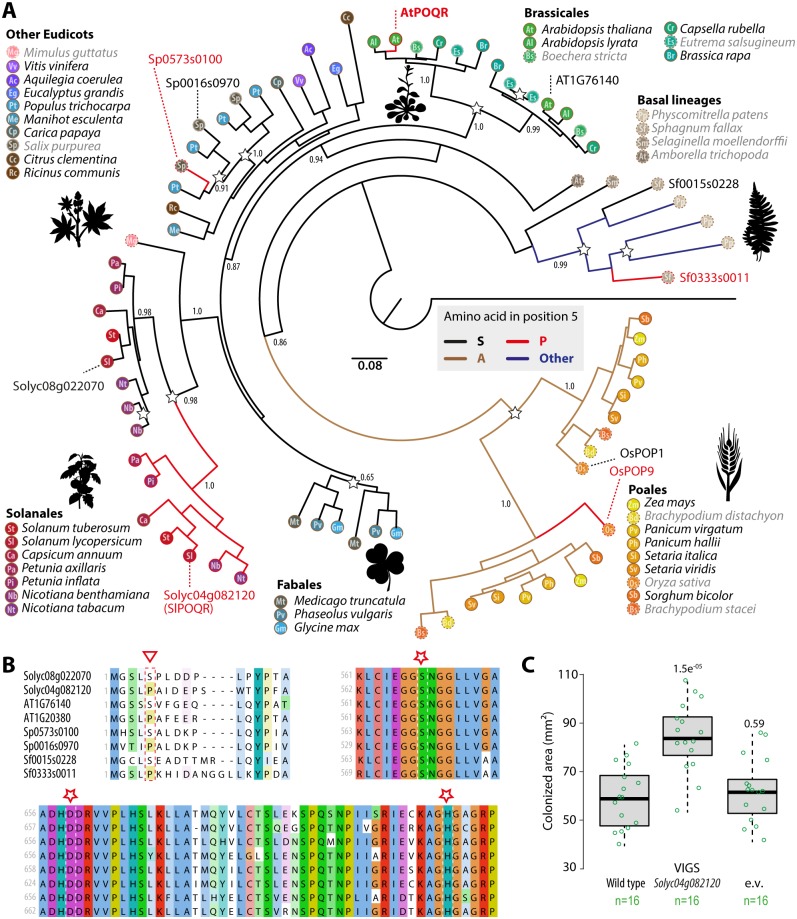
Parallel sequence evolution of POQR homologs in multiple plant lineages.(A) Maximum likelihood phylogenetic tree including the 75 best POQR homologs from 40 plant species. Terminal nodes are colored and labeled according to plant species, following the legend shown around the tree. Species belonging to a genus for which S. sclerotiorum infection has not been reported are shown with dotted nodes and labeled in grey (data from https://nt.ars-grin.gov/fungaldatabases/). Support corresponding to an SH-like approximate likelihood-ratio test is shown for major branches. Branches are colored according to amino acid in position 5 of POQR sequences. POQR homologs from Sphagnum fallax, Arabidopsis thaliana, Solanum lycopersicum, Salix purpurea and Oryza sativa are labeled with corresponding identifiers from the Phytozome database. (B) Multiple sequence alignment of POQR homologs from Sphagnum fallax, Arabidopsis thaliana, Solanum lycopersicum, Salix purpurea and Oryza sativa showing diversity at position 5 (triangle) and conservation of the catalytic triad (stars). (C) Measure of leaf area colonized by S. sclerotiorum 24 hours after inoculation in wild type tomato plants, plants silenced for POQR by virus induced gene silencing (VIGS) and plants carrying the empty viral vector (e.v.). Values are shown for n = 16 individual plants per genotype from two independent biological experiments. Significance of the difference from wild type was assessed by a Student’s t test with Benjamini-Hochberg correction for multiple testing (p-values indicated above boxes).